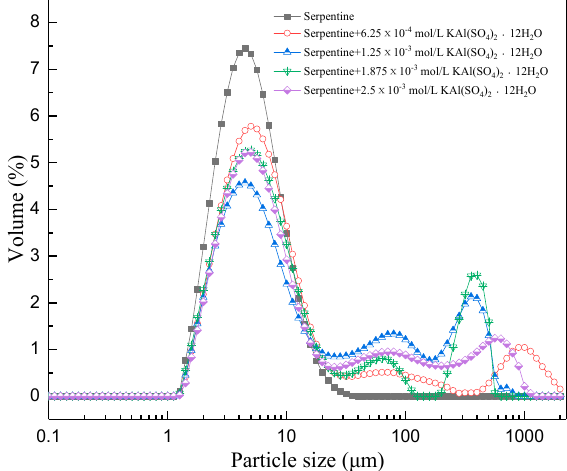
Figure 6. Effect of the presence and absence of KAl(SO 4 ) 2 ·12H 2 O on the particle size distribution of serpentine (pH =